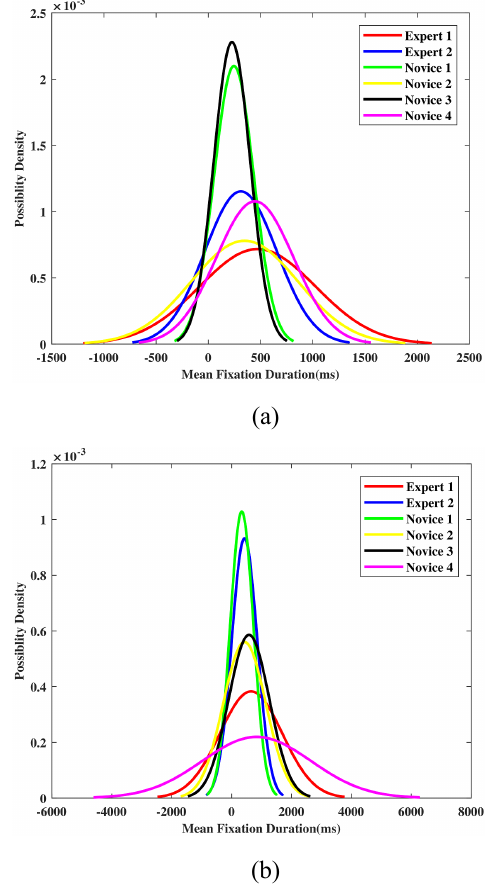
Figure 7: Mean fixation duration with standard deviation at (a) target stage one, and (b) target stage